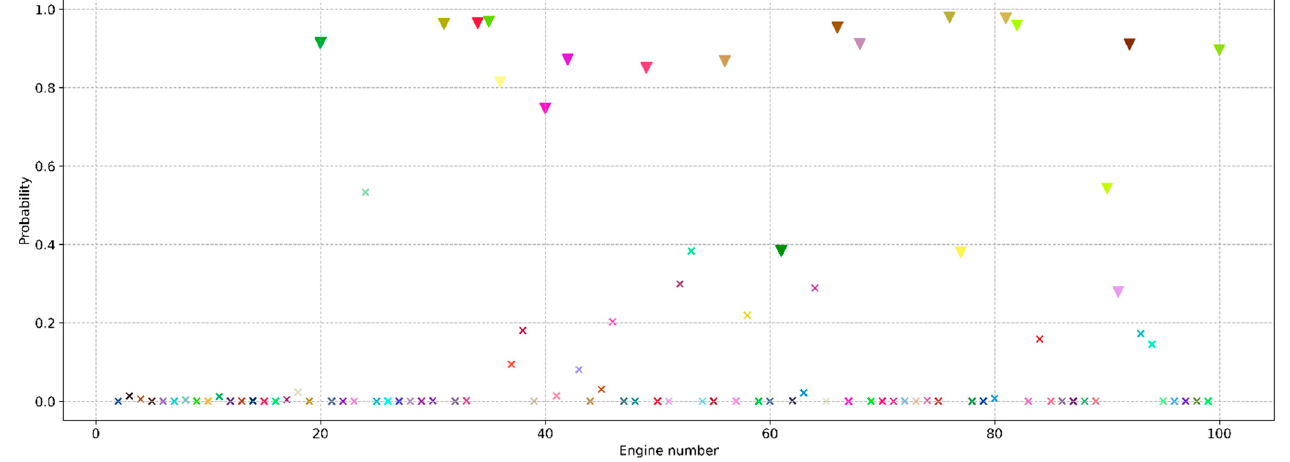
Figure 10. Probabilities of engine failure in the next 30 cycles for the model trained on simplified data, where the triangles are the engines from the considered cluster.